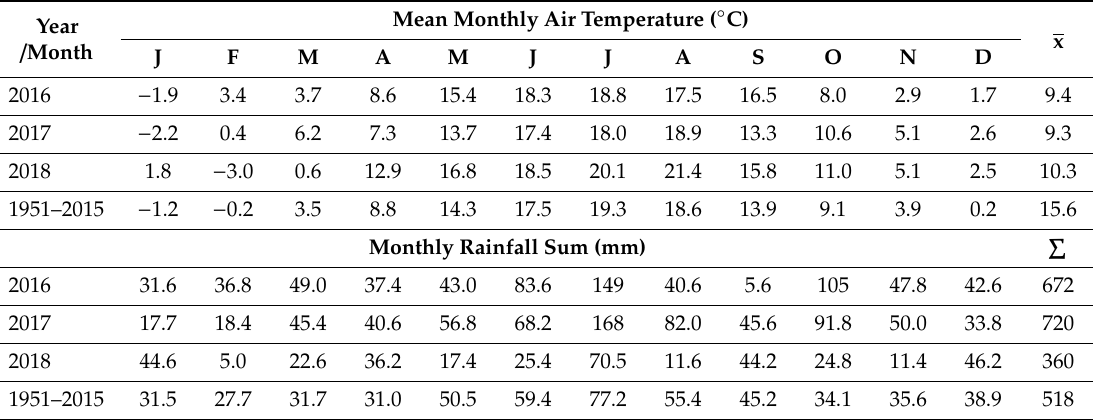
Table 1. Mean monthly air temperature ( ◦ C) and rainfall (mm) sum in 2016–2018 and long-term average (recorded at the agrometeorological observatory in Złotniki, Poland).